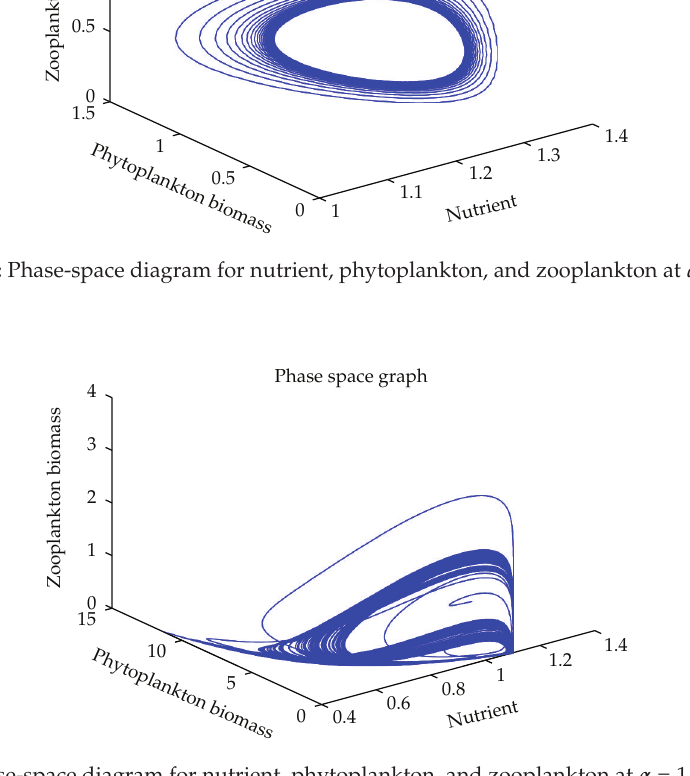
Figure 5: Phase-space diagram for nutrient, phytoplankton, and zooplankton at α (cid:7) 1 . 1, α 1 (cid:7) 0 .